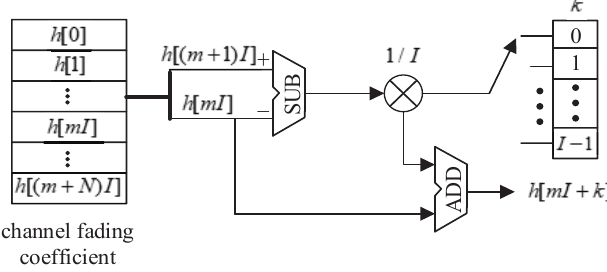
Figure 7. The implementation scheme of interpolation module.